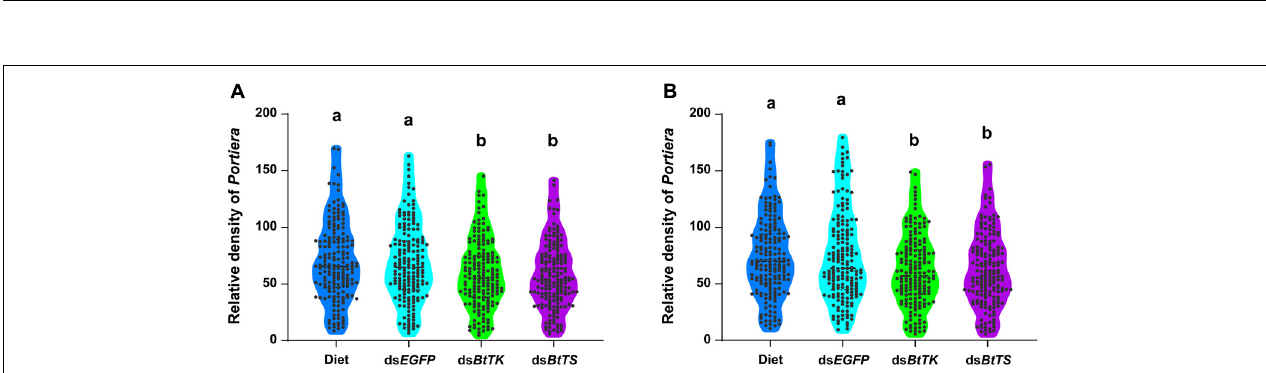
FIGURE 5 | Temporal dynamics of Portiera in B. tabaci MED fed dsRNA or artificial diet. (A) Density of Portiera in B. tabaci MED after 2 days of treatment. (B) The density of Portiera in B. tabaci MED after 4 days of treatment. The changes in symbiont density were measured in terms of the number of 16S rRNA gene copies per β -actin gene copy. The different letters indicate treatment differences at p < 0.05 (one-way ANOVA with Tukey’s test).